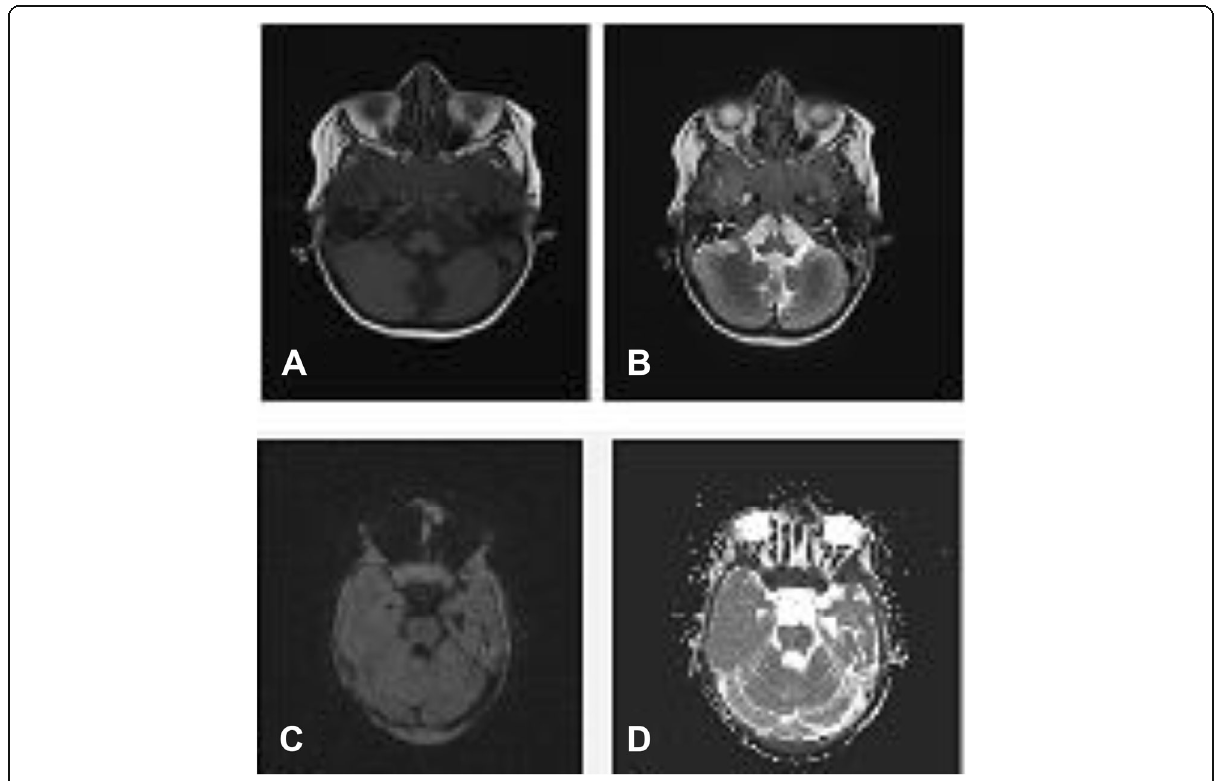
Fig. 11 Skull bone infiltration. Male patient, 7 years old, diagnosed with ALL seen initially at presentation. Axial MRI images of the brain at the level of skull base: a axial non-contrast T1WI, b axial T2WI, c axial DWI, and d axial ADC images show diffusion bone marrow infiltration with cortical expansion and diffusion restriction in DWI and ADC